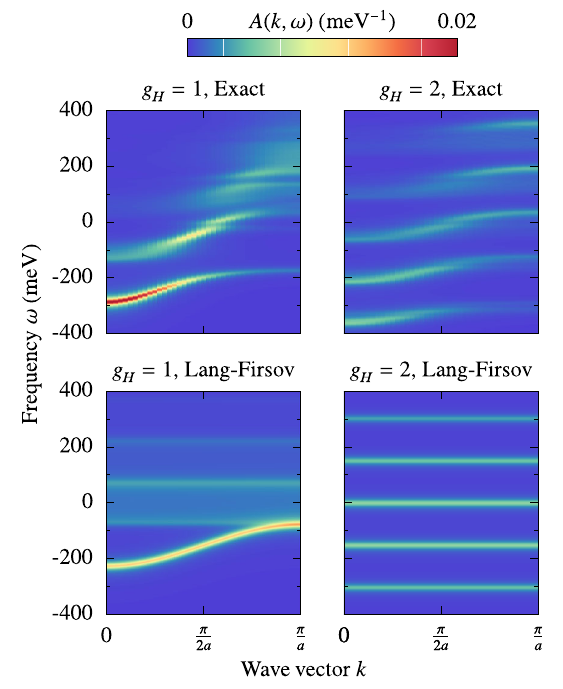
FIG. 5. Momentum-resolved spectral function A ð k; ω Þ at zero temperature obtained by numerically exact EDVHS results (top row) and approximate Lang-Firsov treatment (bottom row) at two different values of the Holstein electron-phonon coupling constant g . Results are calculated with the electronic transfer integral H τ ¼ 100 meV, Holstein phonon frequency ω Lorentzian broadening with η ¼ 10